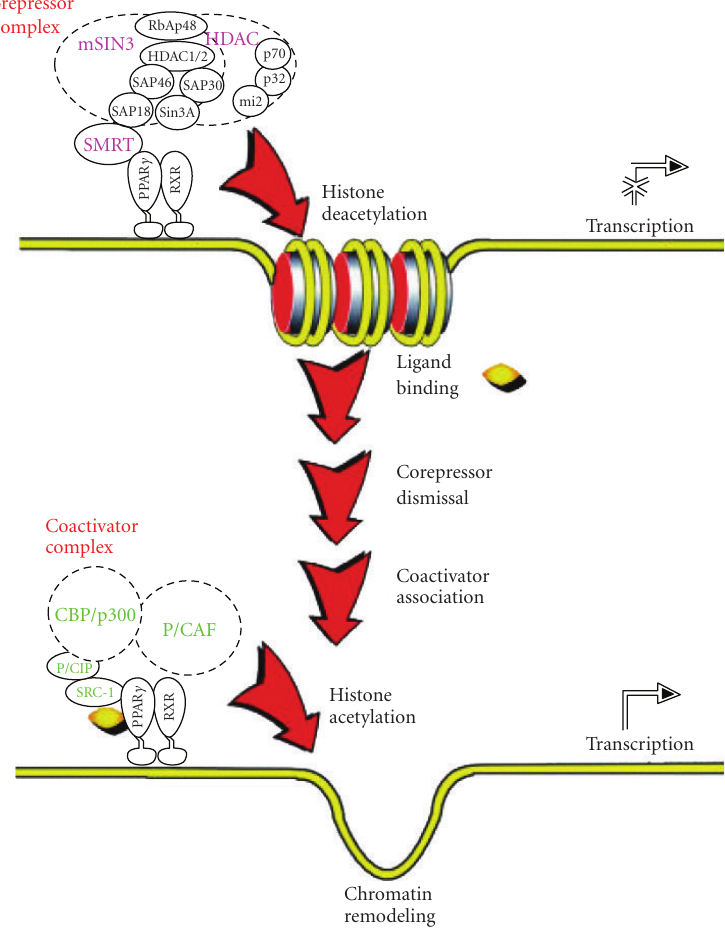
Figure 3: Schematic diagram of the mechanisms of PPAR γ action. In the unliganded state (top), the PPAR γ receptor exists as a heterodimer with the RXR nuclear receptor and the heterodimer is located on a PPAR response element (PPRE) of a target gene. The unliganded receptor heterodimer complex is associated with a multicomponent corepressor complex, which physically interacts with the PPAR γ receptor through silencing mediator for retinoid and thyroid hormone receptors (SMRT). The corepressor complex contains histone deacetylase (HDAC) activity, and the deacetylated state of histone inhibits transcription. After PPAR γ ligand binding, the corepressor complex is dismissed, and a coactivator complex is recruited to the heterodimer PPAR γ receptor (bottom). The coactivator complex contains histone acetylase activity, leading to chromatin remodeling, facilitating active transcription. (Adapted with permission from: J. M. Olefsky, “Treatment of insulin resistance with peroxisome proliferator-activated receptor gamma agonists.” Journal of Clinical Investigation, vol. 106, no. 4, pp. 467-472, 2000); C. K. Glass, M. G. Rosenfeld, “The coregulator exchange in transcriptional functions of nuclear receptors”. Genes & Development,vol. 14, no. 2, pp. 121-141,